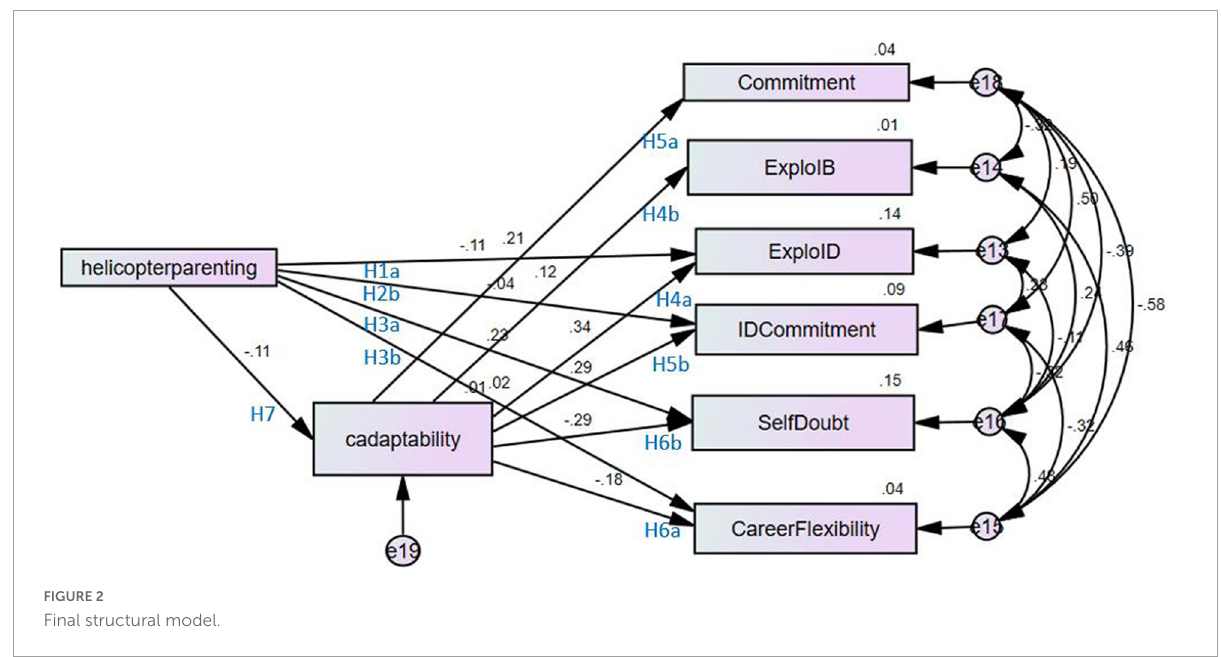
FIGURE2 Final structural model.